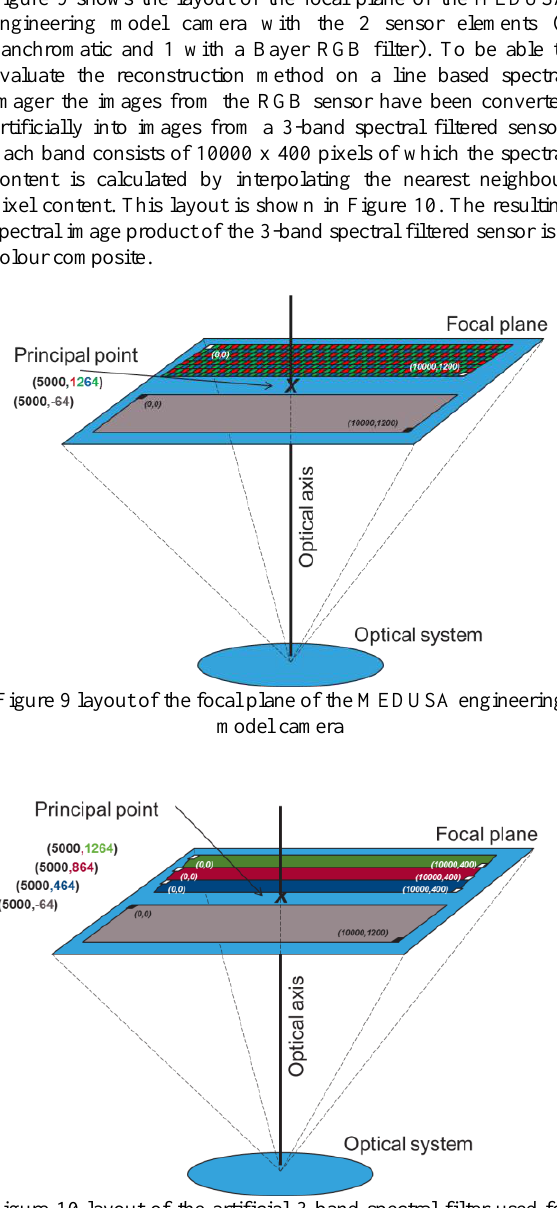
Figure 10 layout of the artificial 3-band spectral filter used for the MEDUSA case study